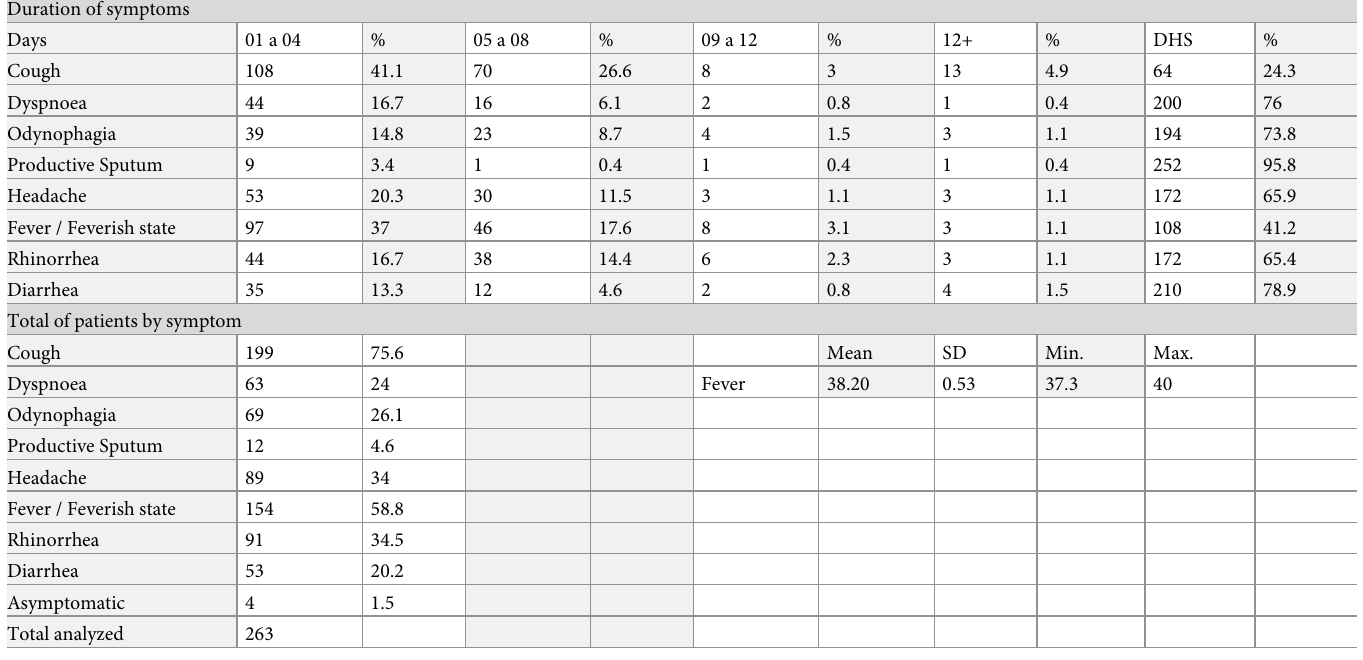
Table 3. Time of symptoms and prevalence collected on admission to the emergency